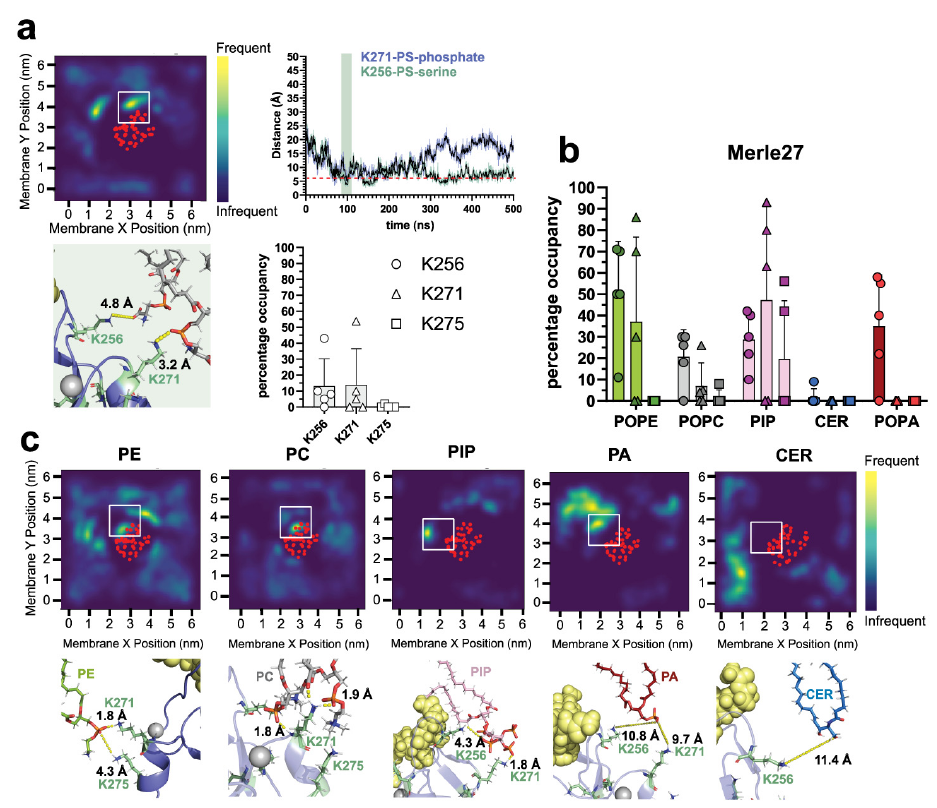
Figure 5. Lipid interactions with δ C1b-Merle27. ( a ) Interactions between δ C1b-Merle27 and PS. Representative heatmap indicates the frequency of PS in the lower leaflet over 500 ns (complete data set is shown in Figure S2). Interaction lifetimes are shown in the xy plot for the residues indicated. Example hydrogen bonding patterns are shown in the green box and are taken from the shaded region of the interaction lifetime plot. Quantification of PS-lysine interactions are shown in the grey bar graph. ( b ) Quantification of the interaction of δ C1b-Merle27 with various lipids. ( c ) Heatmaps showing the frequency of lipid localization in the inner leaflet over the 500 ns simulation time. Heatmaps are representative of five simulations and the red dots indicate the average position of the C α backbone of δ C1b. Representative structures are shown below from regions indicated by the white box. Lysine residues are shown as pale-green sticks and the ligand is represented as yellow spheres. Bars indicate the mean, error bars represent the standard error of the mean and each point represents a single independent simulation.